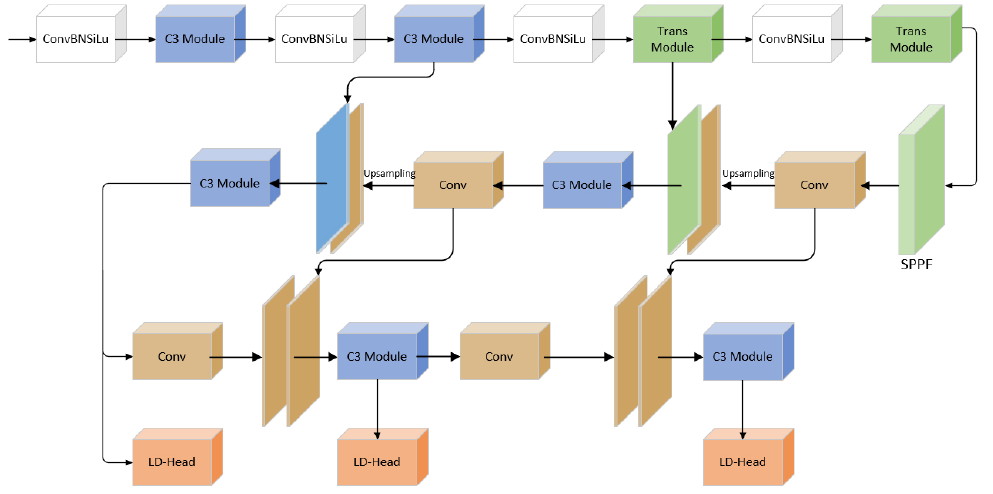
Figure 1. The architecture of